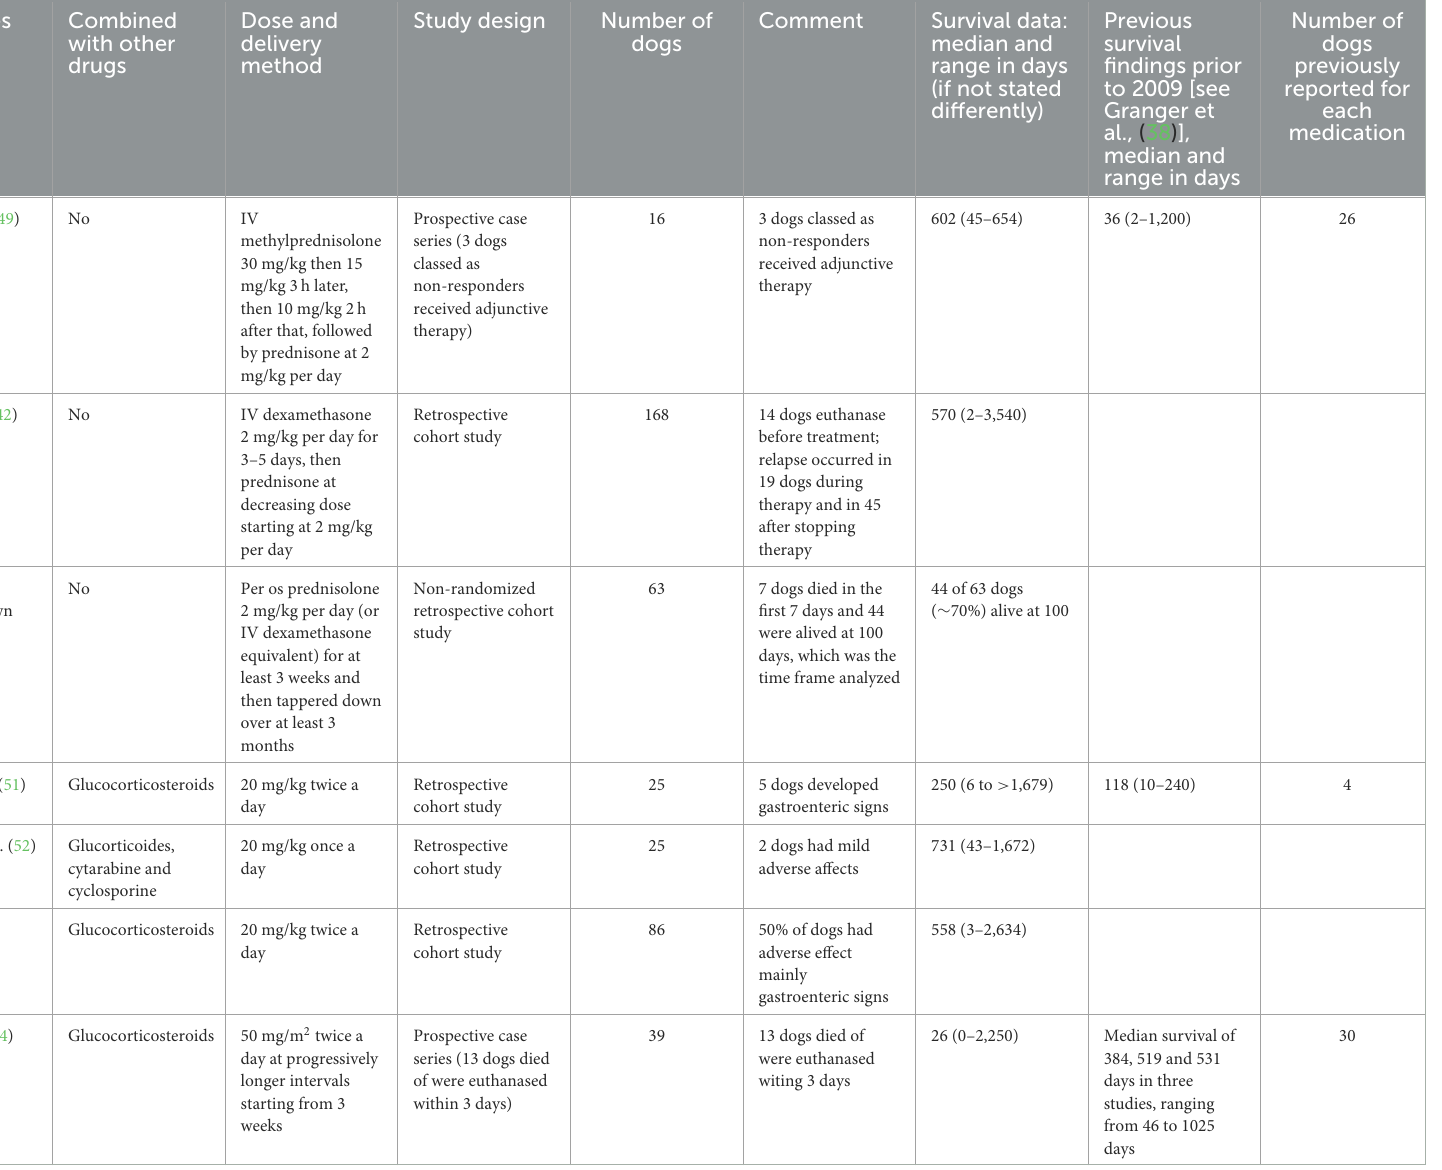
TABLE 1 Summary of treatments and outcomes in dogs with meningoencephalitis of unknown origin published since